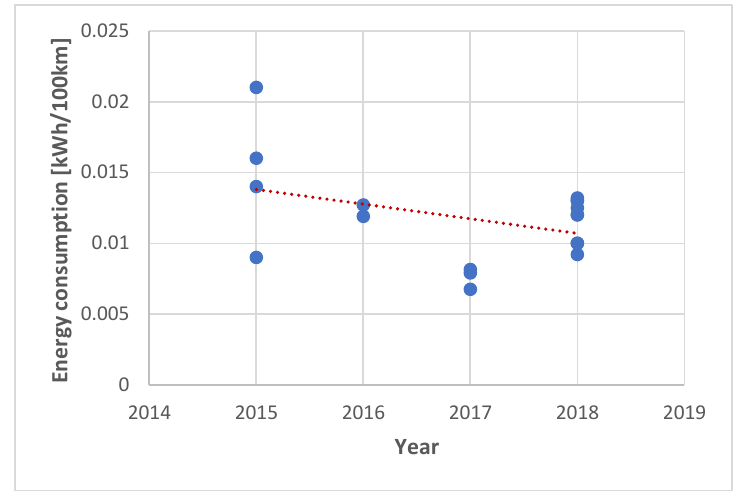
Figure 8. Energy consumption of electric buses from 2015 to 2018.